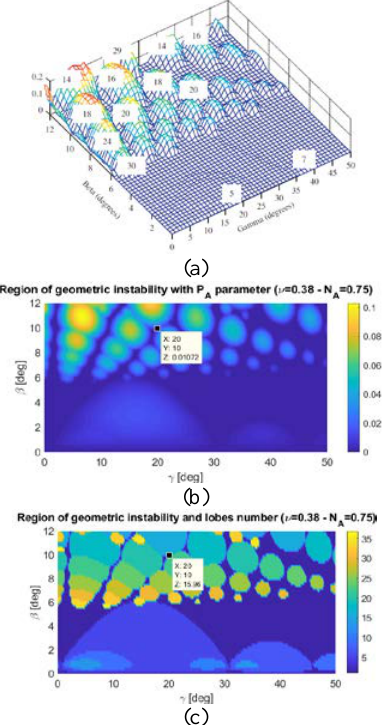
Fig. 9. Regions of geometric instability measured by PA parameter: a) imposing an integer number of lobes (Rowe 25); b) by the proposed approach, with free lobe number: c) resulting number of lobes. The noted point is the examined example .